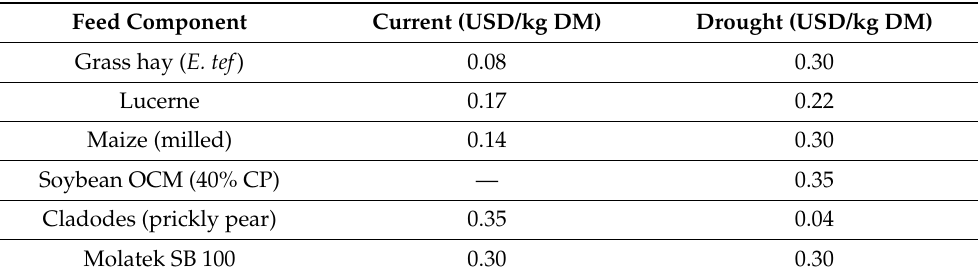
Table 3. Feed ingredients prices (USD/kg DM) used for spineless cactus feed formulation for drought and current